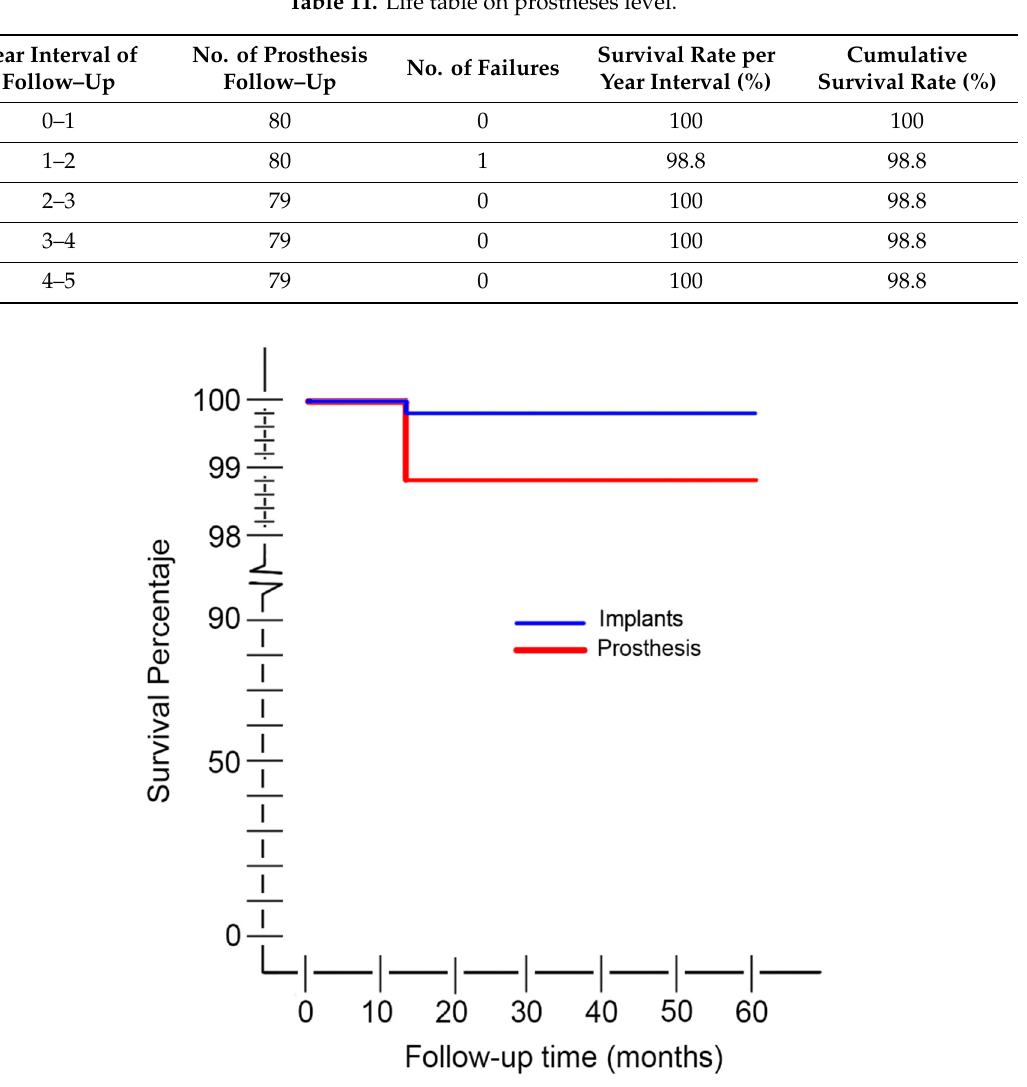
Table 11. Life table on prostheses level.